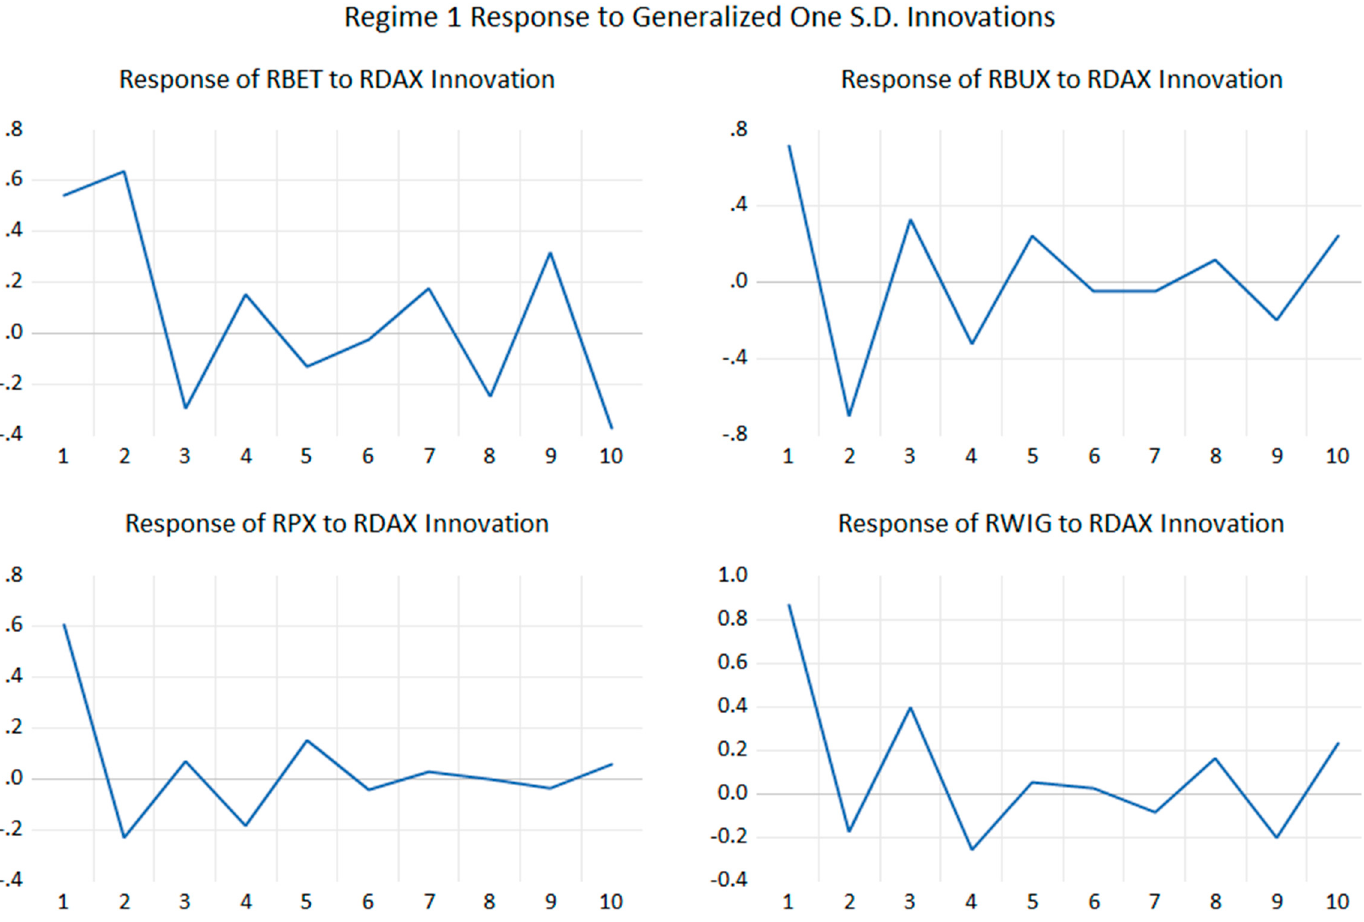
Figure A10. Cont